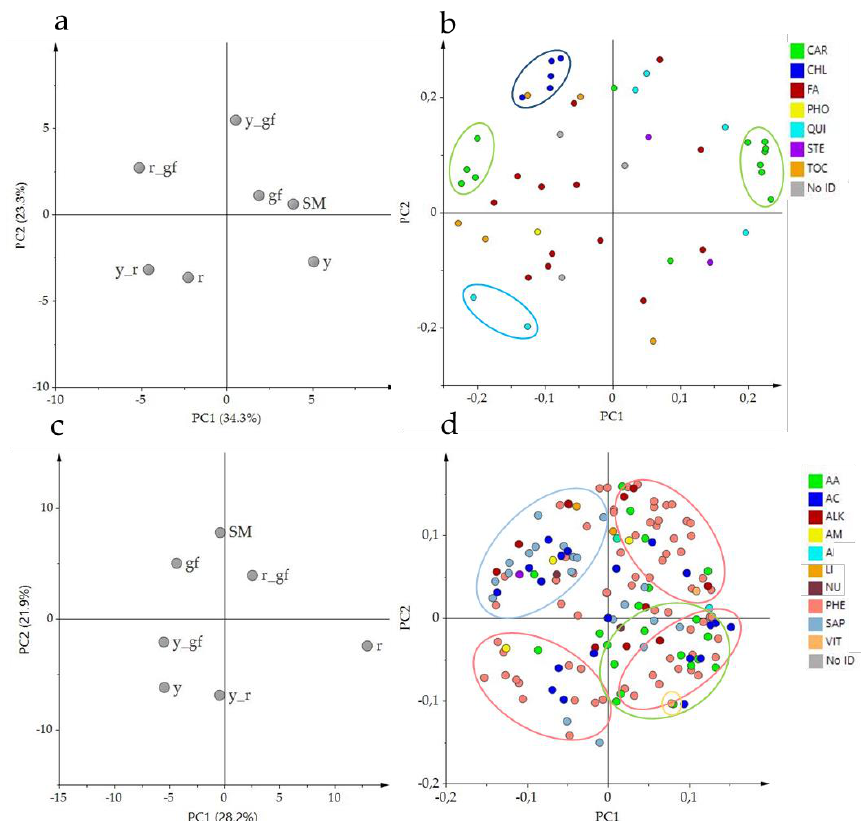
Figure 4. PCA of log2 values of 54 NP ( a , b ) and 128 P ( c , d ) metabolites measured by LC-HRMS. ( a – c ) PC1 × PC2 score plot of the six mutated lines plus San Marzano (SM). ( b – d ) PC1 × PC2 corresponding loading plots. Line ( a , c ) and metabolite class ( b , d ) abbreviations are explained in Tables 1 and 2